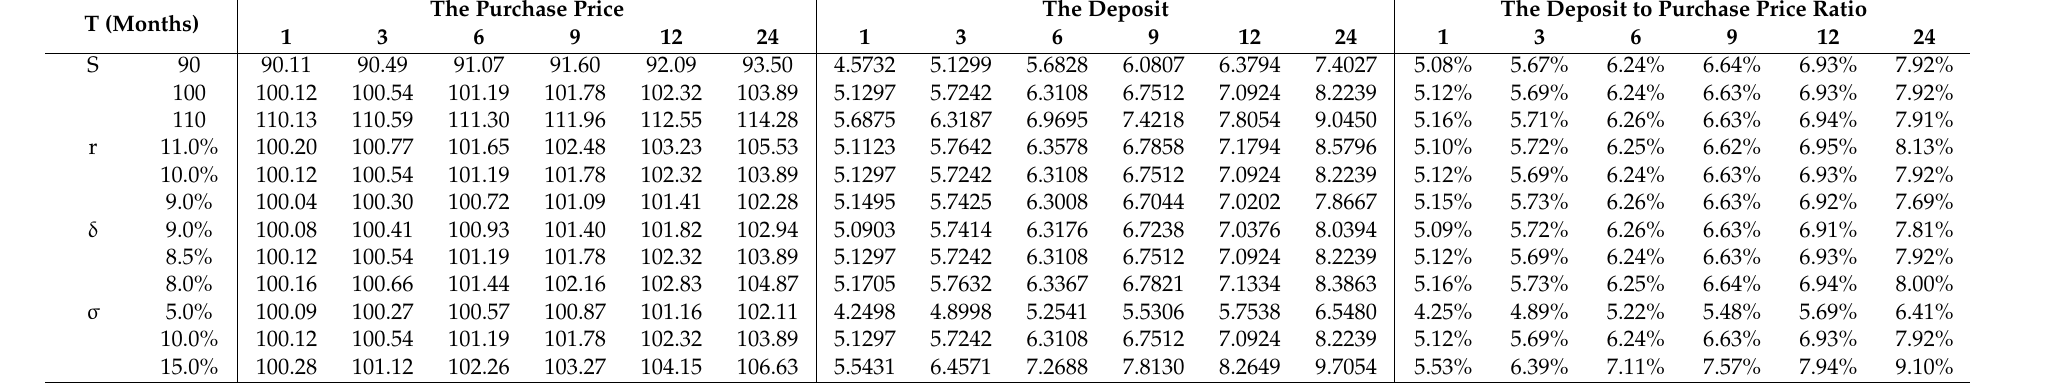
Table 3. The Deposit and Purchase Price are